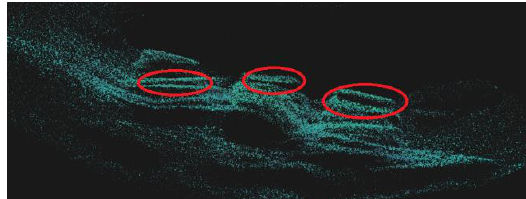
Figure 14. Lipari without global registration